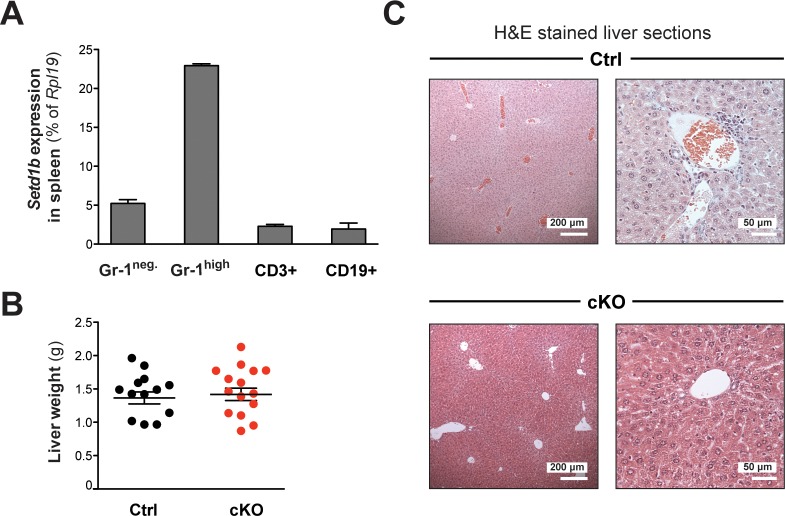
Setd1b expression in differentiated cell types and liver phenotype.(A) qRT-PCR analysis of Setd1b expression in splenic cell populations. Setd1b mRNA was detected in all FACS-sorted populations from WT mice (n = 3) relative to Rpl19 expression. The mean ± SD is illustrated. (B) The liver weights of cKO and control littermates between 10 and 25 weeks after tamoxifen induction were comparable (Ctrl n = 13, cKO n = 15). The graph depicts the mean ± SEM (data derived from seven independent tamoxifen inductions). (C) H&E staining of liver sections. In cKO mice, the liver architecture was normal without apparent myeloid cell infiltrations. Empty blood vessels indicated an anemic condition.